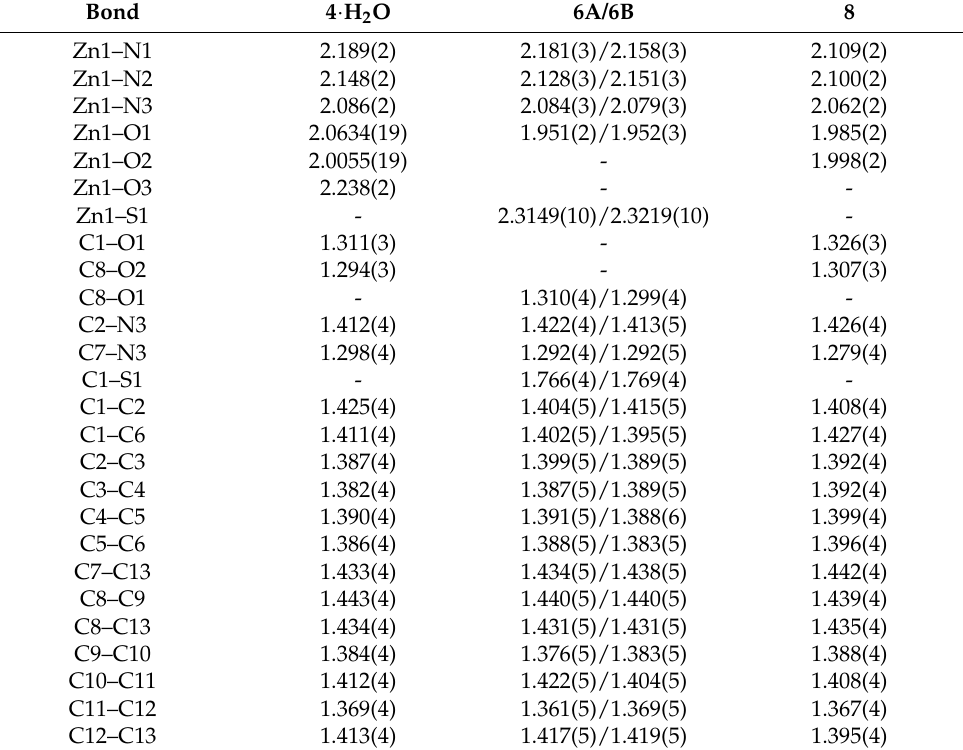
Table 1. The selected bond lengths (Å) in 4 · H 2 O, 6 , and 8 according to the X-ray analysis data.